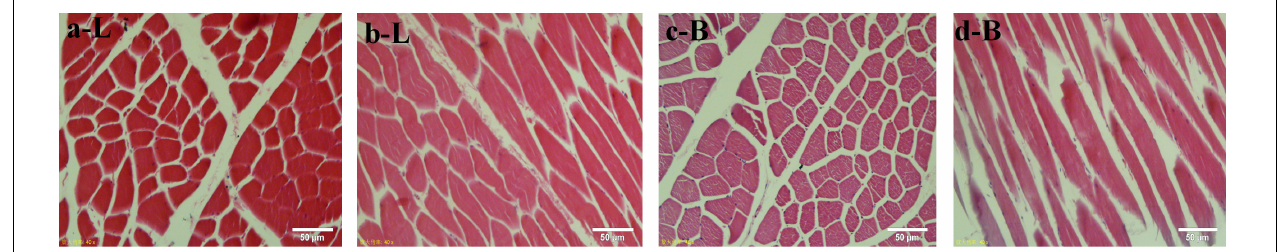
FIGURE 1 | HE staining of muscle tissue paraffin sections. Red represents a single muscle fiber, blue represents a nucleus (marked by arrows); a and c stand for tissue crosscutting, b and d stand for tissue longitudinal cutting; L stands for Luxi cattle, B stands for Shandong black cattle.